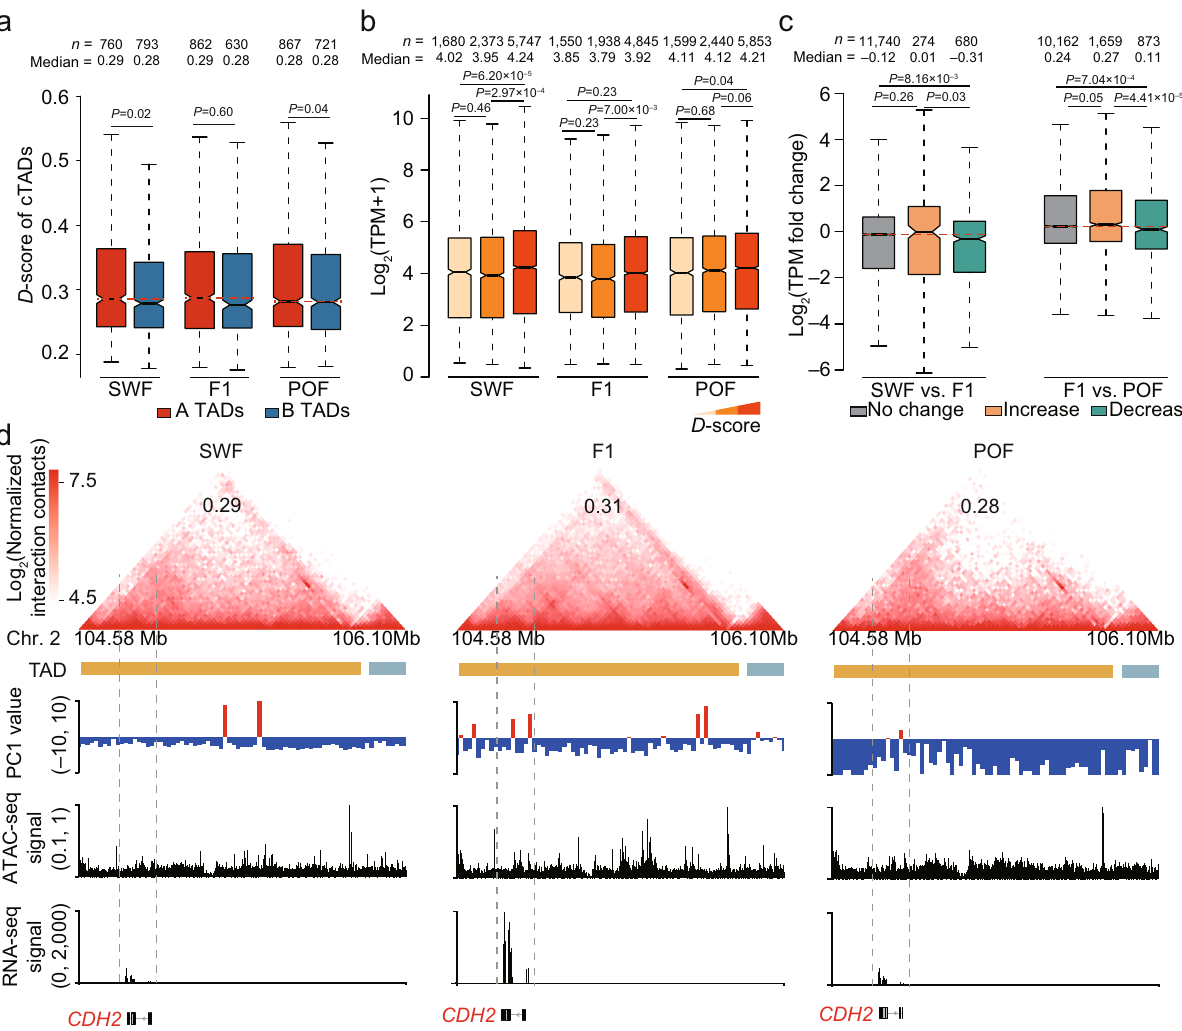
Fig. 5 Interaction dynamics in consensus TADs during folliculogenesis in chicken GCs. a D -scores of consensus TADs located in the A and B compartments at each stage. b Expression levels of genes in consensus TADs ( n = 1831) with a relatively low, medium, or high D -score. c Expression changes in genes with signi fi cantly increased, decreased, or stable D -scores between adjacent stages. d A representative TAD with differential D -scores during folliculogenesis. Top: Hi-C contact heatmaps of the genomic region containing CDH2 (Chr.2: 104.58 – 106.10Mb). D -score values of the TADs were marked. Middle: TAD boundaries and genome browser tracks of PC1 values, ATAC-seq signals, and gene expression levels. Bottom: gene structures in the genomic region. The dashed line boxes indicate the chromosomal locations of the genes (red). For a , b , and c , the internal line indicates the median, the box limits indicate the upper and lower quartiles and the whiskers extend to 1.5 IQR from the quartiles. P -values in a were calculated using one-sided Student ’ s t test. P values in b and c were calculated using two-sided Wilcoxon rank-sum test. Source data are provided as a Source Data fi